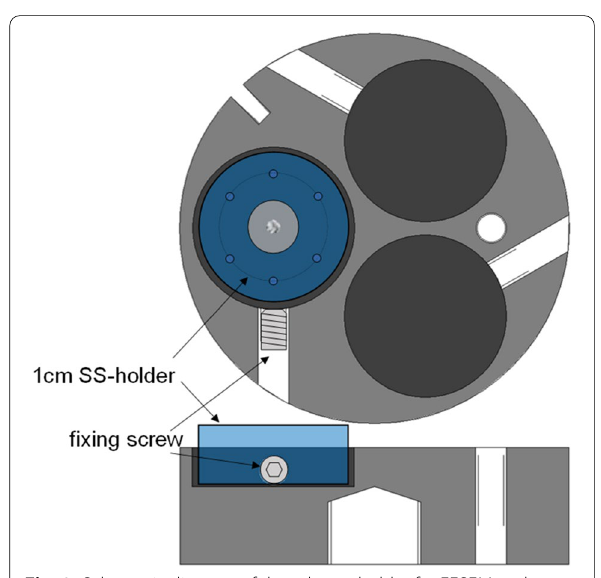
Fig. 8 Schematic diagram of the adapter holder for FESEM and FTIR analyses. Three 1 cm SS-holders can be installed in one adapter holder, and be fasten individually using fixing